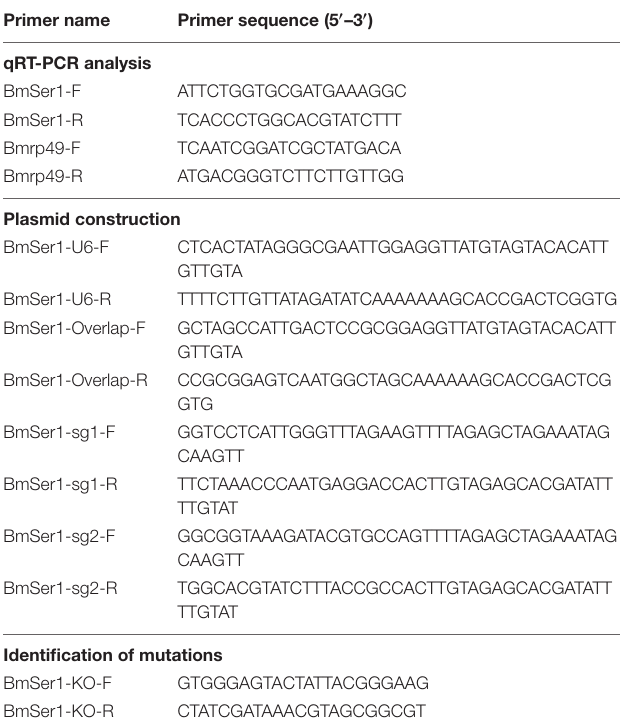
TABLE 1 | Primers used in PCR amplification and plasmid construction.